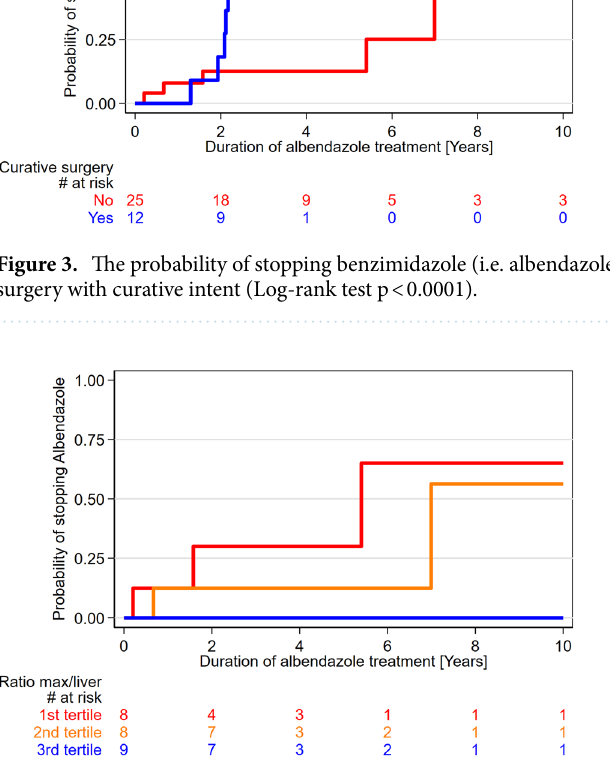
Figure 4. The graph displays a trend (test for trend of survivor function; p = 0.05) toward higher probability of stopping benzimidazole (i.e. albendazole) therapy over time in patients with lower SUVratio (i.e., median SUVratio in the first, second and third tertile were 1.23, 2.01 and